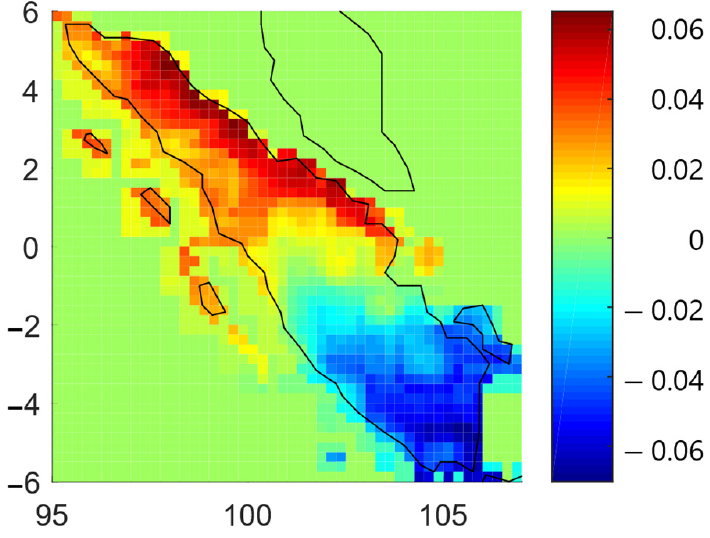
Figure 1. Precipitation types of Sumatra.